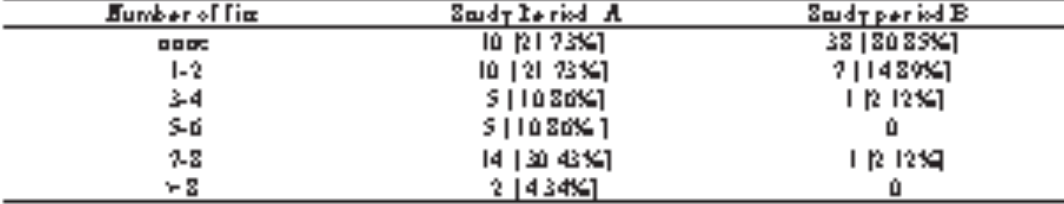
Table VII : Recurrent fits: Number of fits after intervention